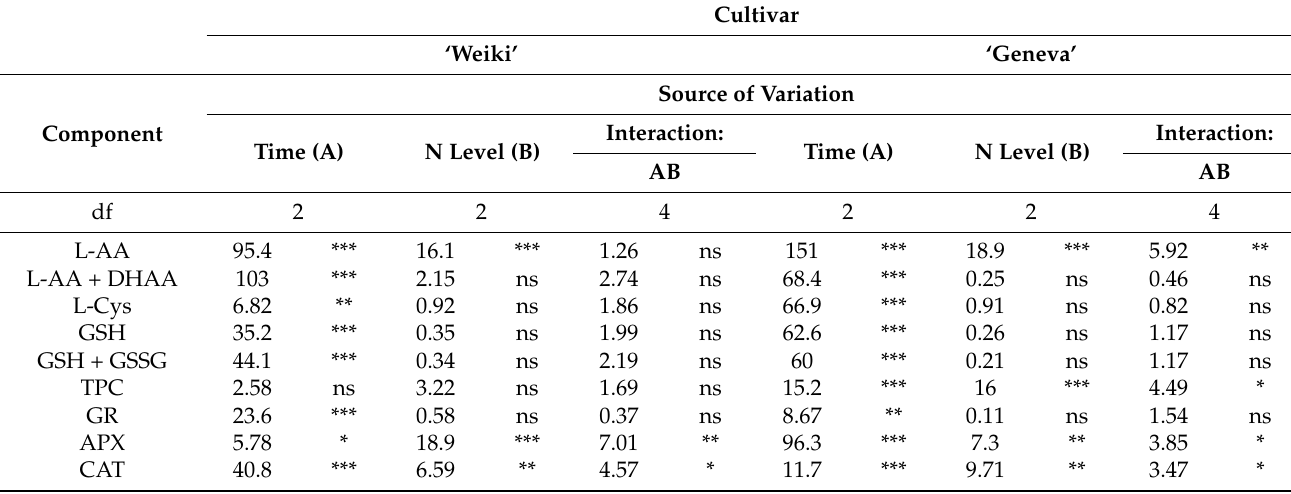
Figure 1. Data on average temperatures and rainfall at the experimental site in the 2015, 2016 and 2017 growing period. Long-term averages calculated for each month (I–XII) in the period 1982–2012 were − 4.3, − 3, 1.9, 8.2, 13.1, 16.5, 17.9, 17.4, 13.4, 8.7, 3, − 1.6 ◦ C and 25, 24, 28, 35, 57, 72, 75, 62, 44, 36, 39, 34 mm for temperature and rainfall respectively. Average temperature and rainfall for the period 1982–2012 were 7.6 ◦ C and 44.25 mm respectively. Table 1. Summary of analysis of variance (ANOVA) for the components tested. Values of F for particular sources of variation and their significance depending on the cultivar.